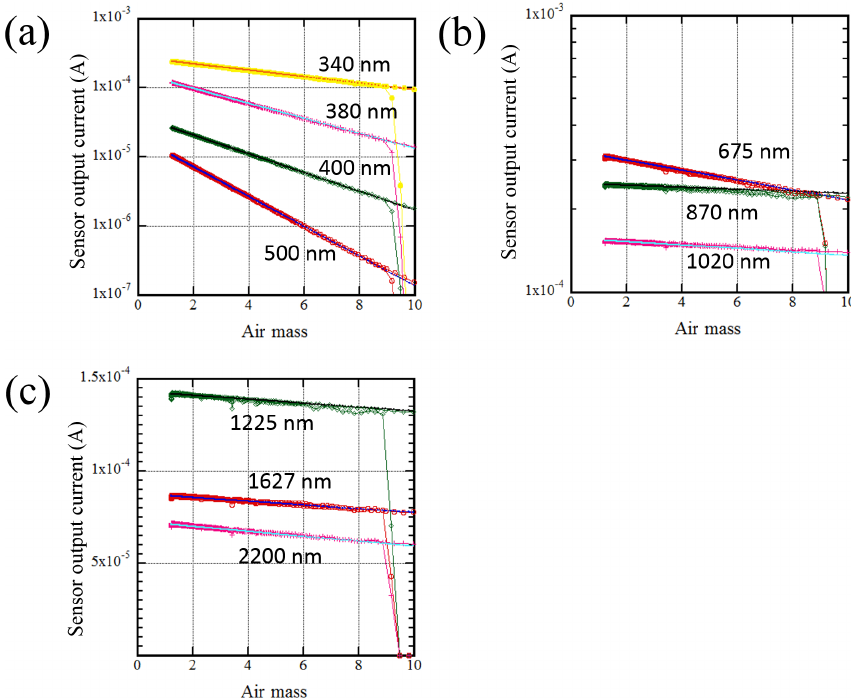
Figure 4. Examples of Langley plots using the data obtained at MLO, on 3 November 2015. The sensor output of POM-02 is current: the unit is ampere